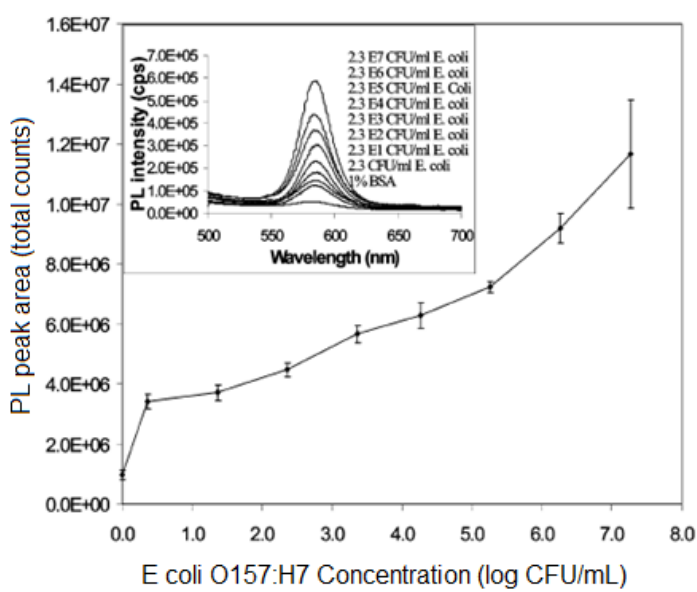
Figure 8. The curve of the photolu.minescence (PL) vs the concentration of E. coli O157:H7. Inset: PL spectra of the BSA and E. coli O157:H7 samples taken under the same conditions at the same excitation wavelength